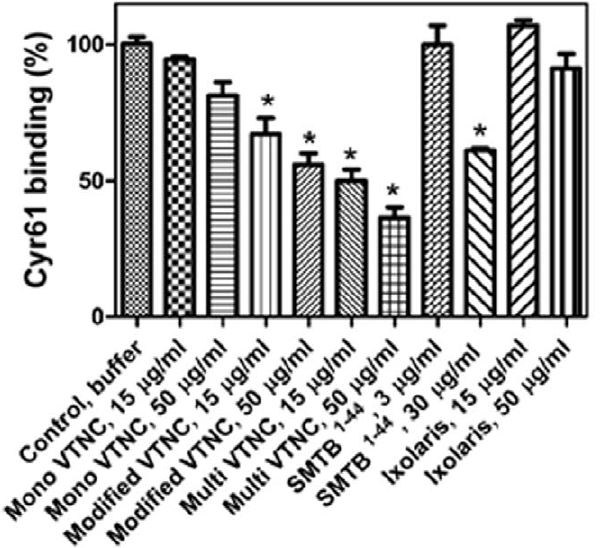
Figure 6. Cyr61 prevents U937 cell adhesion to vitronectin. uPAR-bearing U937 cells were incubated for 120 minutes with VTNC- coated wells previously incubated with buffer or Cyr61 or PAI-1 (1.5 m M) as described in Materials and Methods. As a control, wells were coated with gelatin only. One hundred % cell adhesion was estimated in the presence of buffer (vehicle) only, and 0% as adhesion to gelatin. Results from quintuplicate experiments are shown.